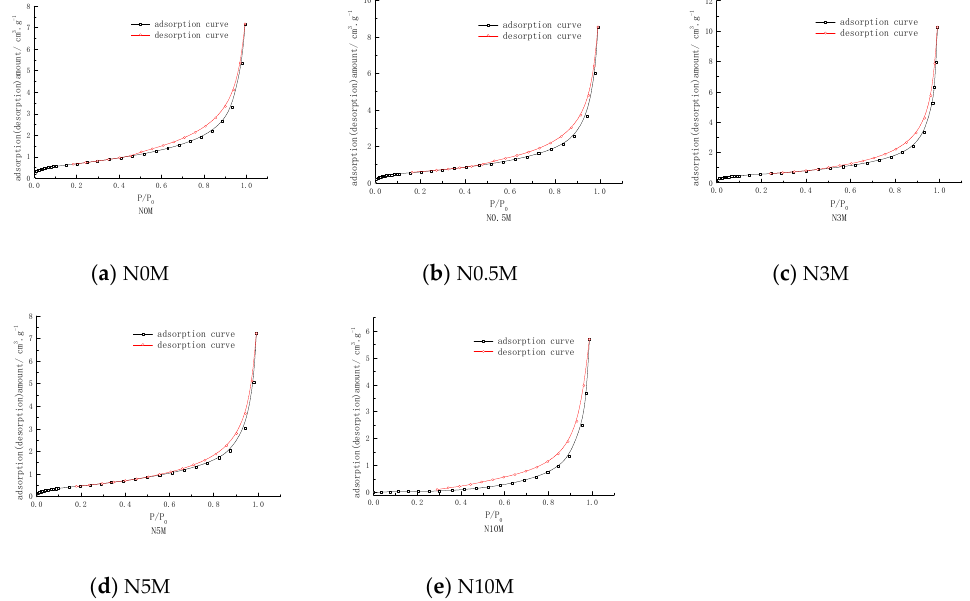
Figure 3. Nitrogen adsorption–desorption curves of coal treated with different nitric acid concentrations.